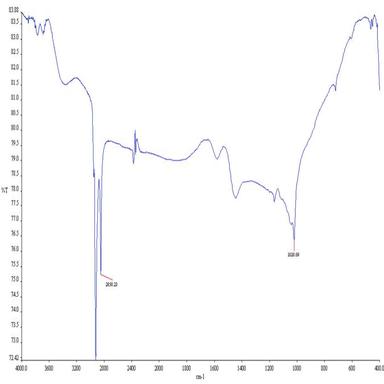
FTIR spectra of n-dodecyl iodide (one of the precursor).